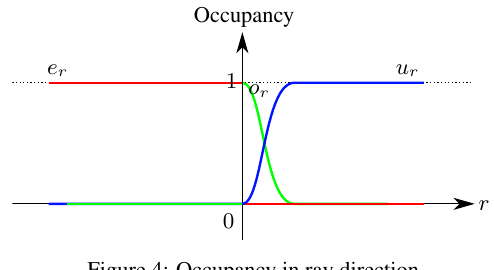
Figure 4: Occupancy in ray direction